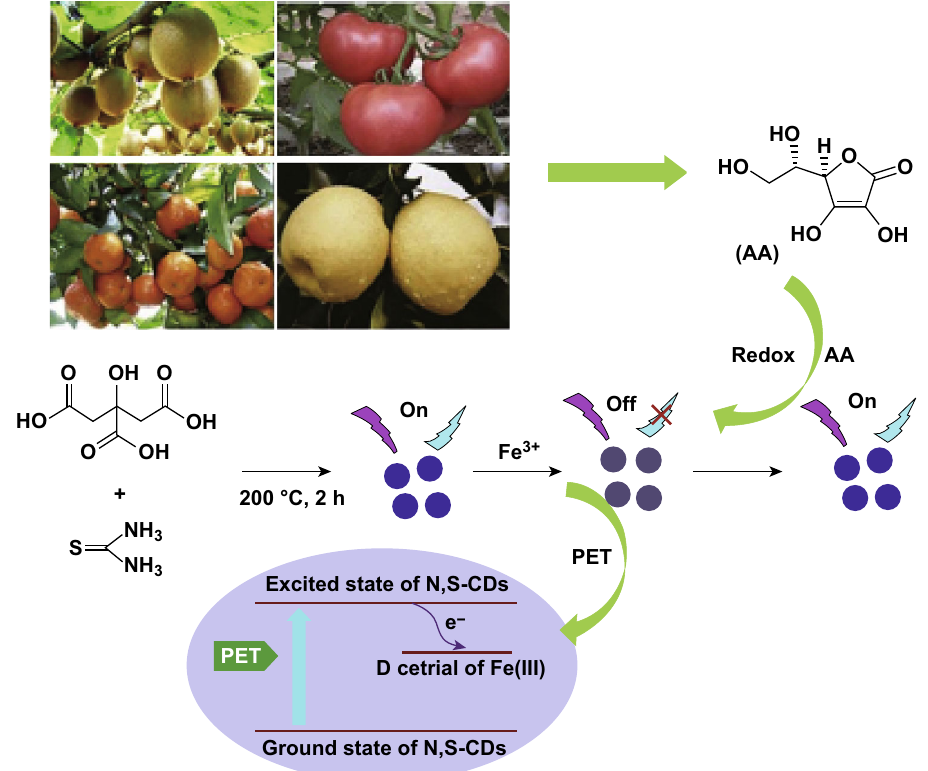
Fig. 20 Schematic illustration of N, S-co-doped CDs for the detection of ascorbic acid in fruit [254]. Copyright (cid:2) 2018 Elsevier